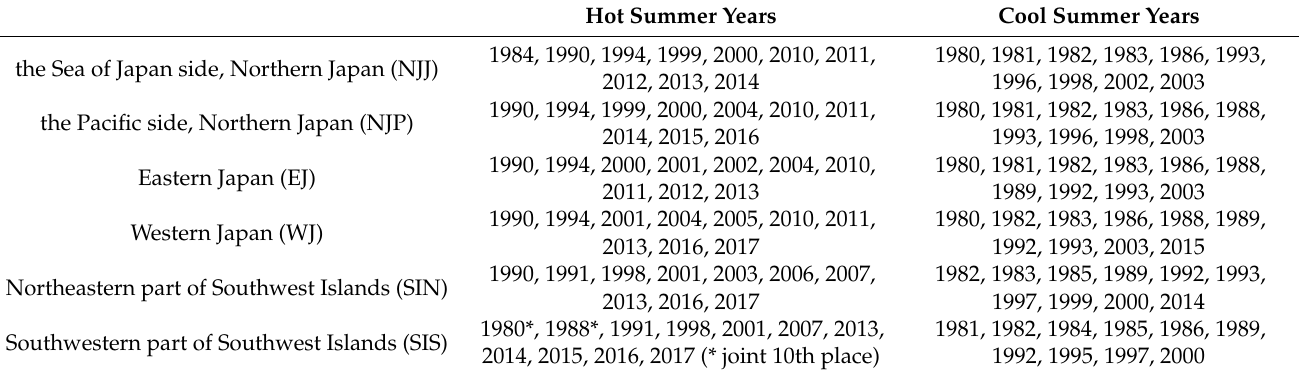
Table 2. Classification results for hot and cool summer years in six regions of Japan. Hot Summer Years Cool Summer